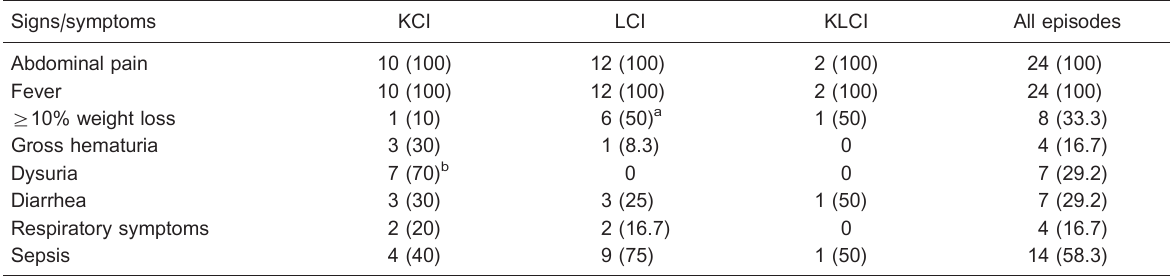
Table 1. Clinical manifestations at hospital admission in patients with autosomal dominant polycystic kidney disease/autosomal dominant polycystic liver disease with kidney and/or liver cyst infections.